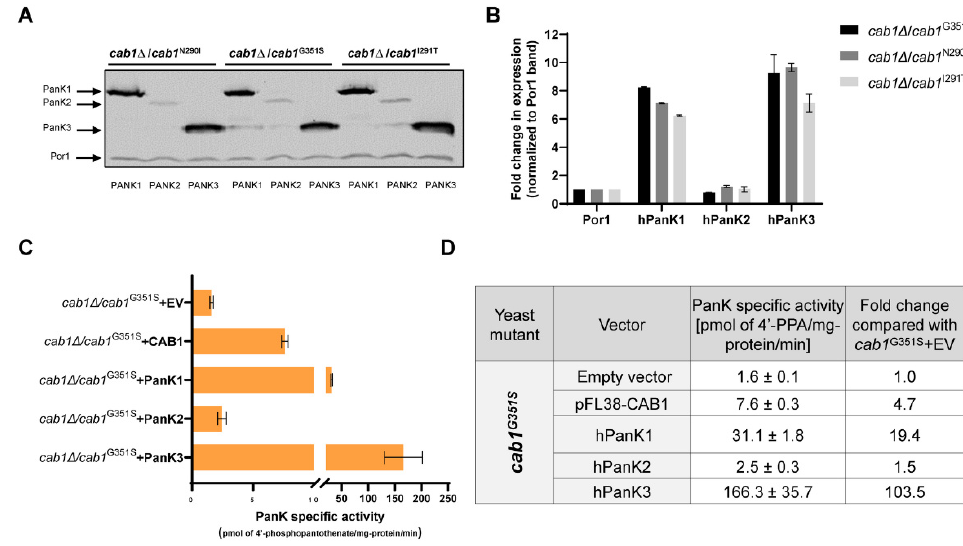
Figure 6 . Expression levels and enzyme activity of hPanK1, hPanK2 mtm Δ and hPanK3 in yeast. ( A ) Western blot analysis using anti-Myc monoclonal antibody on extracts from the yeast mutant strains carrying human PANK1 , PANK2 mtm Δ and PANK3 . ( B ) Quantification of the expression levels of human PanKs in yeast from ( A ) using Image Lab software. The signals were normalized to the control signal ( α -Por1). Values are means ± standard deviation, n = 3. ( C , D ) Cellular pantothenate kinase was measured from fresh cell extracts obtained from cab1 Δ / cab1 G351S yeast cells carrying either the empty vector, yeast CAB1 or human PANK genes. Cells were grown at 30 °C in media containing 2% galactose. The activity assay measures the phosphorylation of D-[1- 14 C] pantothenate as described in Material and Methods.